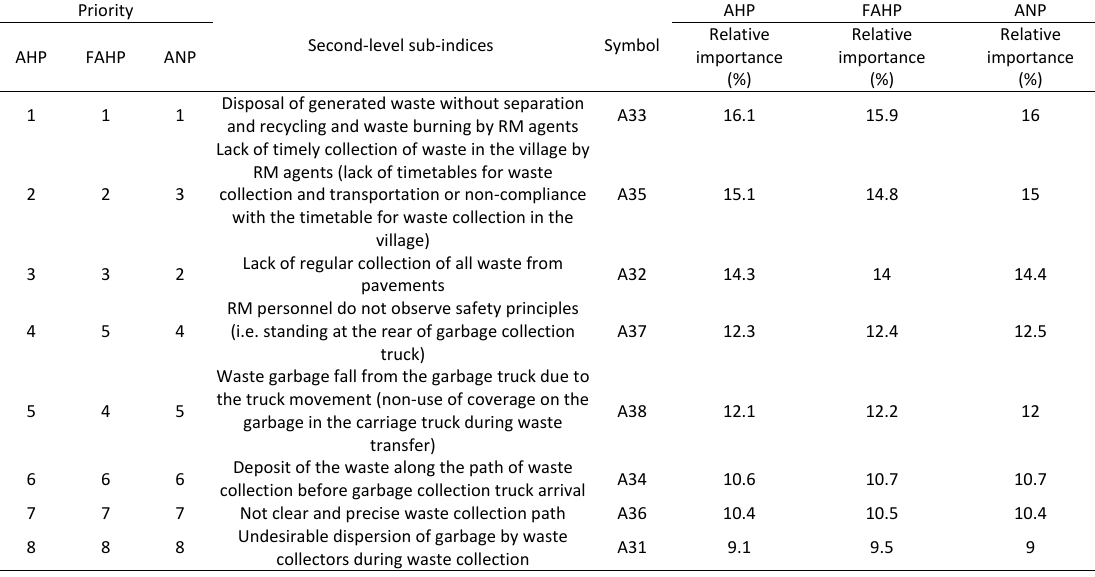
Table 3: Prioritization of weaknesses and relative importance values of the sub-indices of the A3 index based on AHP, FAHP, and ANP